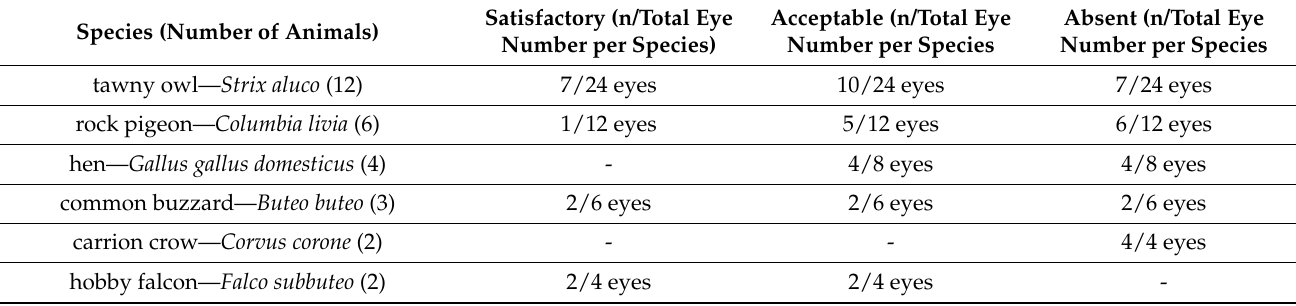
Table 2. Quality of pupil dilation 45 to 60 min after rocuronium instillation in both eyes in the birds included in the